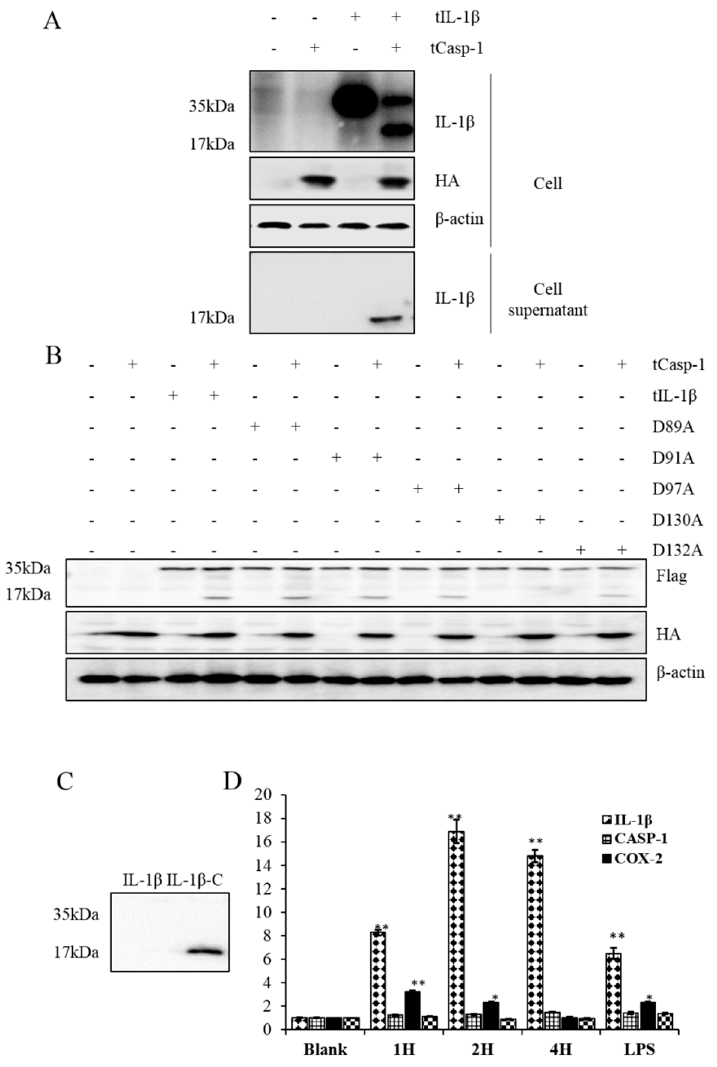
Figure 6. ( A ) The HEK293 cell was transfected with pcDNA ‐ tcasp ‐ 1 ‐ HA and/or pcDNA ‐ tIL ‐ 1 β‐ Flag. Culture supernatant samples and cell lysates were collected 36 h post ‐ transfection and detected by Western blotting; ( B ) HEK293 cells were co ‐ transfected with wild ‐ type pcDNA ‐ tIL ‐ 1 β‐ Flag/mutant plasmids and pcDNA ‐ tcasp ‐ 1 ‐ HA. Whole ‐ cell lysates were subjected to Western blotting for the target proteins; ( C ) Expression of truncated tIL ‐ 1  from D130 to C ‐ terminus in Sf9 cells; ( D ) The mRNA transcripts from stimulated PBMo were normalized to the non ‐ stimulated group and results